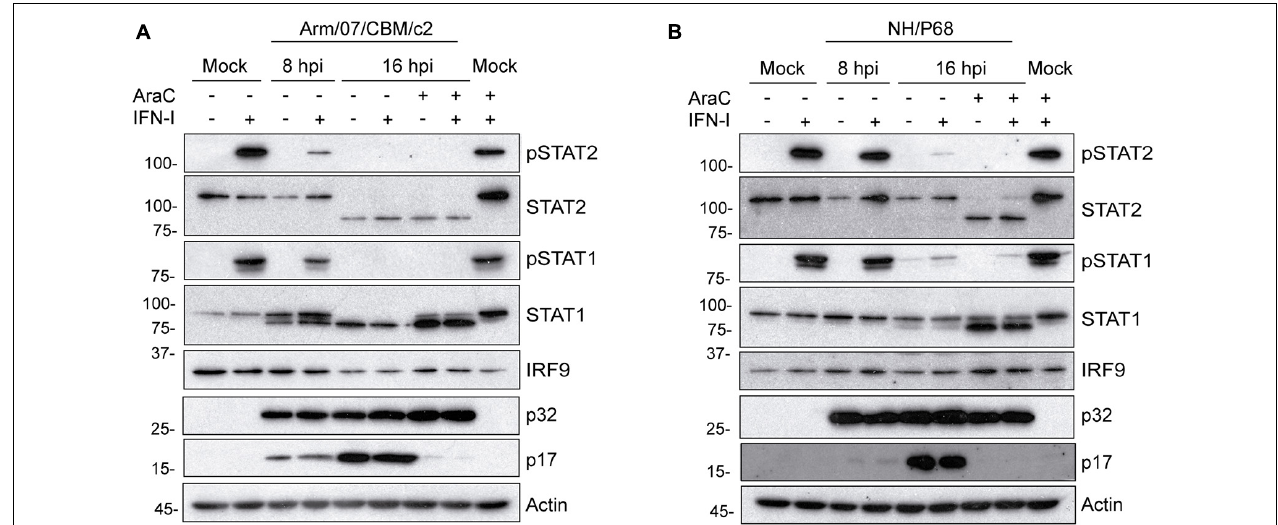
FIGURE 4 | Arm/07/CBM/c2 and NH/P68 interfere with IFN-I signaling by targeting STAT1 and STAT2. PAMs were mock infected or infected with either Arm/07/CBM/c2 (A) or NH/P68 strain (B) (2 PFU/cell) for 8 or 16 h, in absence or in presence of AraC (40 µ g/ml). At 7 or 15 hpi, PAMs were stimulated or not with universal type I IFN (1,000 U/ml). After 1 h of stimulation, cells were collected and lysed in RIPA buffer for further analysis by Western blot. Antibodies against pSTAT2, STAT2, pSTAT1, STAT1, IRF9, early viral protein p32, and actin were employed. As a control of AraC effect on viral DNA replication, a specific antibody against the late viral p17 protein was used, which is only expressed in the absence of